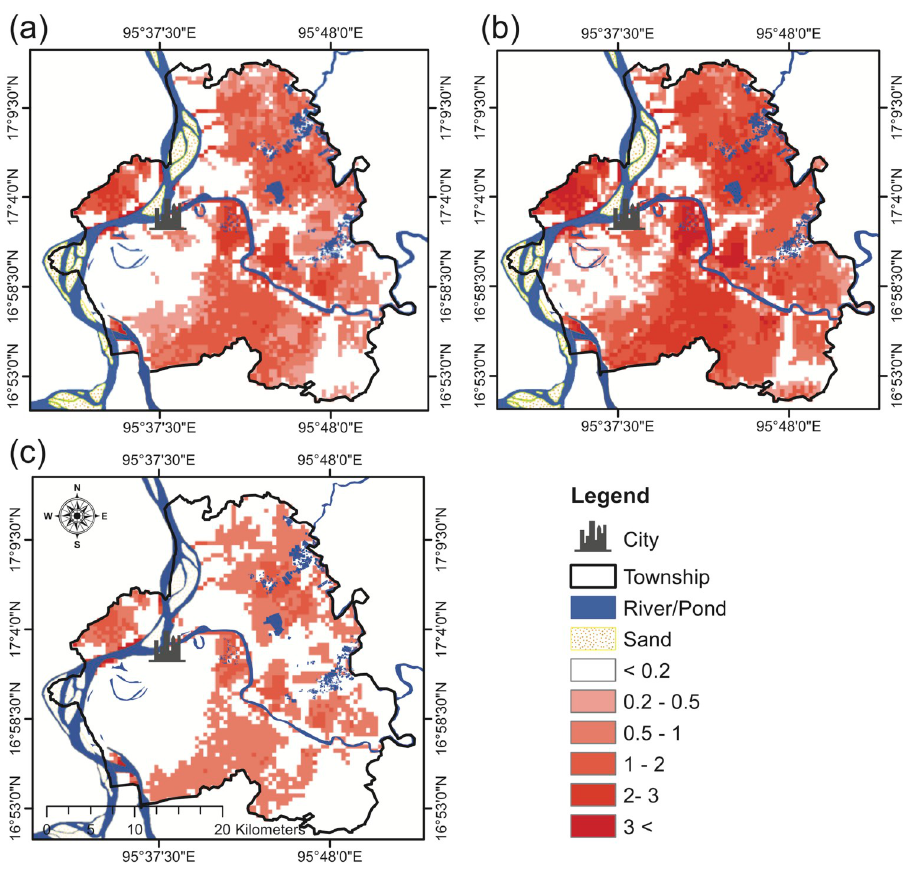
Fig 6. Model-simulated potential flood inundated areas for the (a) 2011 and (b) 2015 (c) 2016 flood events.